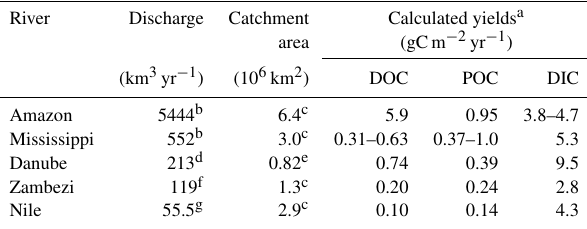
Table 4. Annual discharge, catchment area and carbon yields of selected major